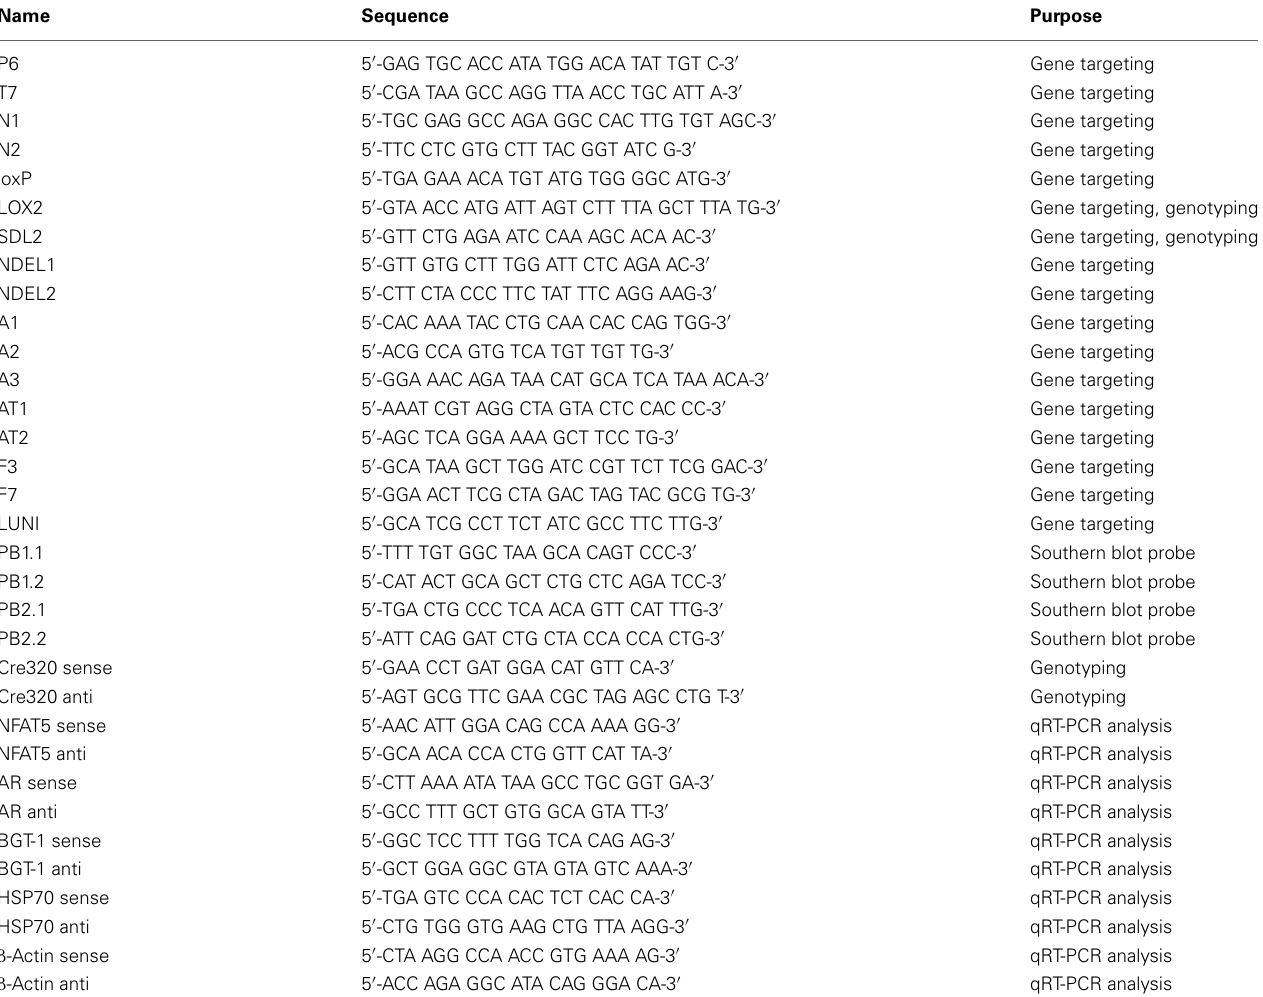
Table 1 | Oligonucleotides used in this